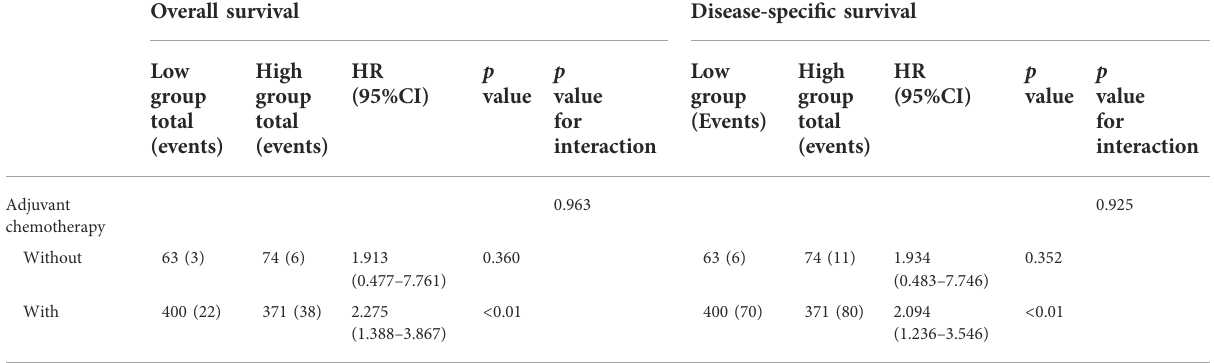
TABLE 3 Effect of p-FAK expression on the prediction of chemotherapy response in CRC